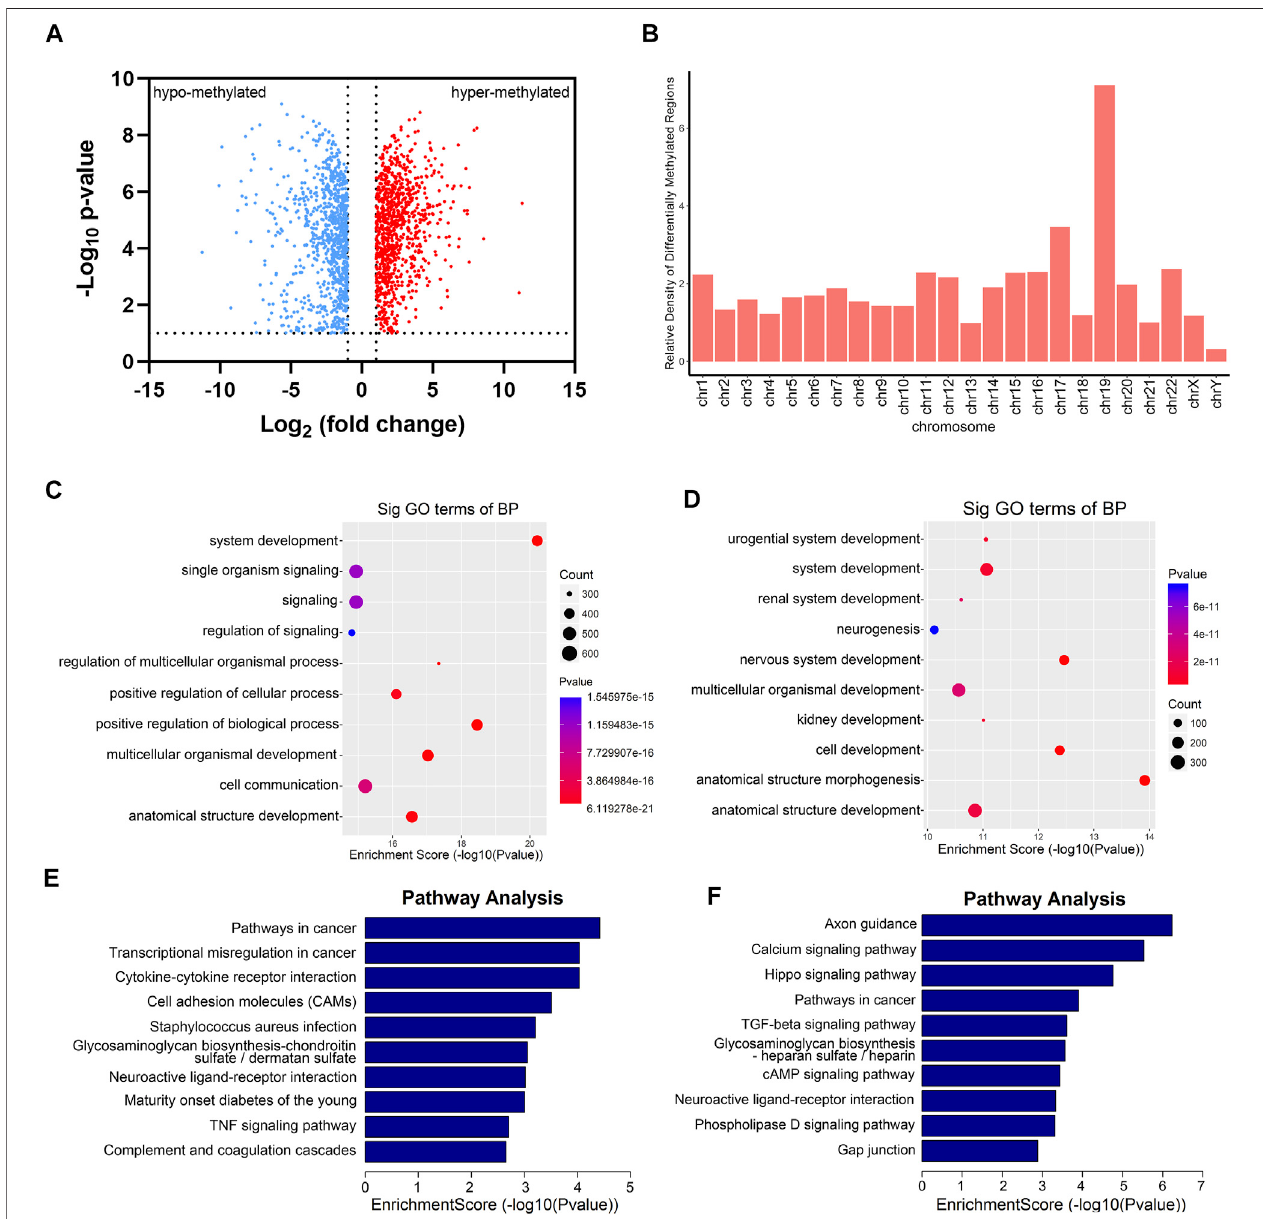
FIGURE 3 | Gene Ontology (GO) and KEGG analysis of DMGs between fi ve paired renal tumor and adjacent tissues. (A) Volcano blot of differentially methylated mRNAs(DMGs)intumorcomparedwithadjacenttissues. (B) Thecontainerofdifferentiallymethylatedm6Asitesharboredbydifferentchromosomes. (C) GOanalysisof hypermethylated genes in RCC tumor tissues. (D) GO analysis of hypomethylated genes in RCC tumor tissues. (E) KEGG analysis of hypermethylated genes in RCC tumor tissues. (F) KEGG analysis of hypomethylated genes in RCC tumor